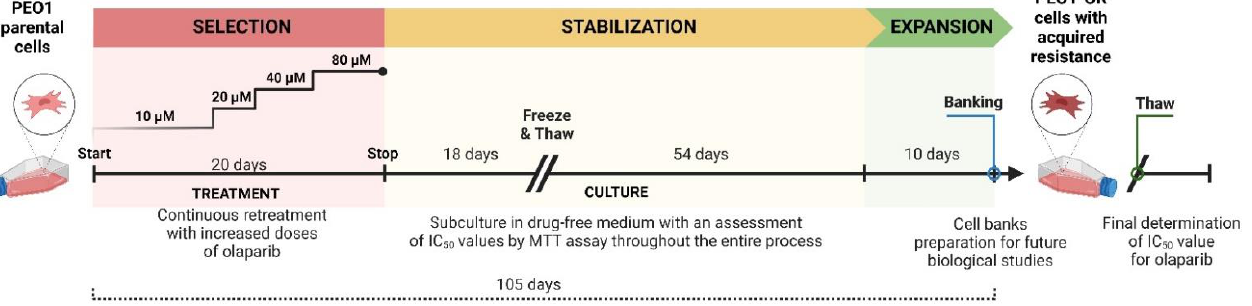
Figure 1. Timeline of a continuous selection strategy and stabilization for generating PEO1-OR cells with a phenotype of acquired resistance to olaparib. In the first round of selection, PEO1 parental cells were seeded at moderate confluence and exposed to 10 μM olaparib, and additional doses of drug were administered every 2–5 days during medium change or cell passage. Next, cells were sequentially cultured in the presence of stepwise increasing doses of olaparib (20, 40, and 80 μM) at each round of selection. After 20 days of treatment, cells were cultured in the absence of drug for a total of 72 days to stabilize changes in sensitivity to the drug and subjected to a single cycle of freeze – thaw to ensure the presence of the resistant phenotype. Eventually, the culture of selected cells was expanded and cryopreserved for future use. Untreated parental cells were cultured alongside those used for olaparib selection throughout the